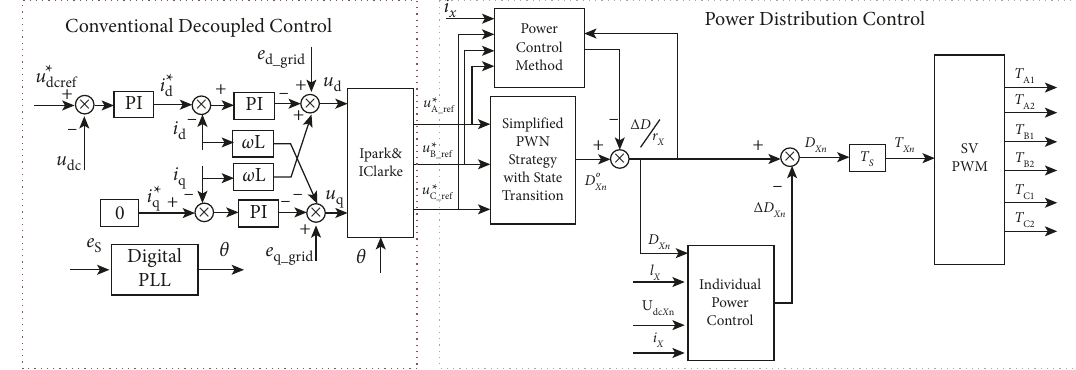
Figure 3: Control block diagram of the grid-connected inverter system.